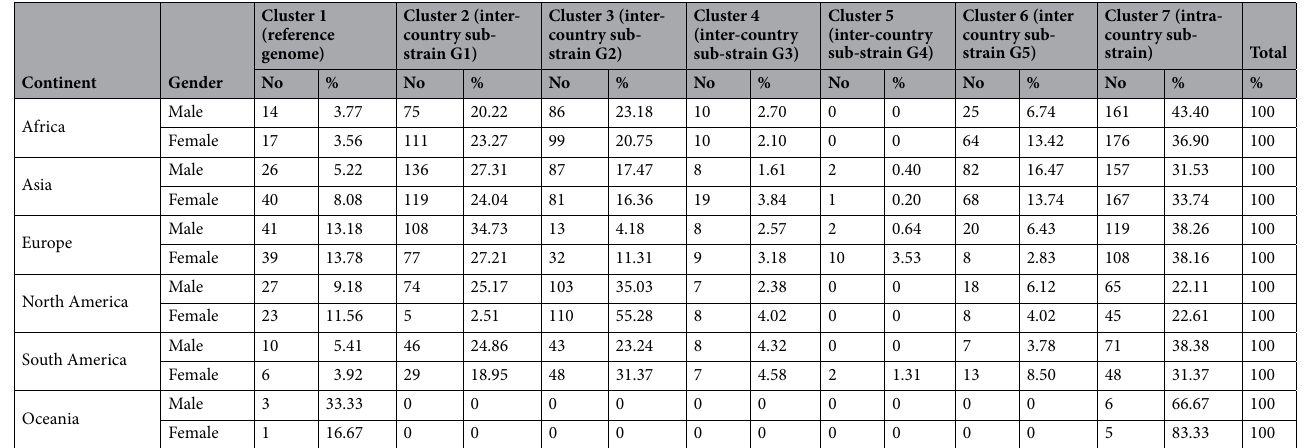
Table 5. Cluster distribution by gender across continents.